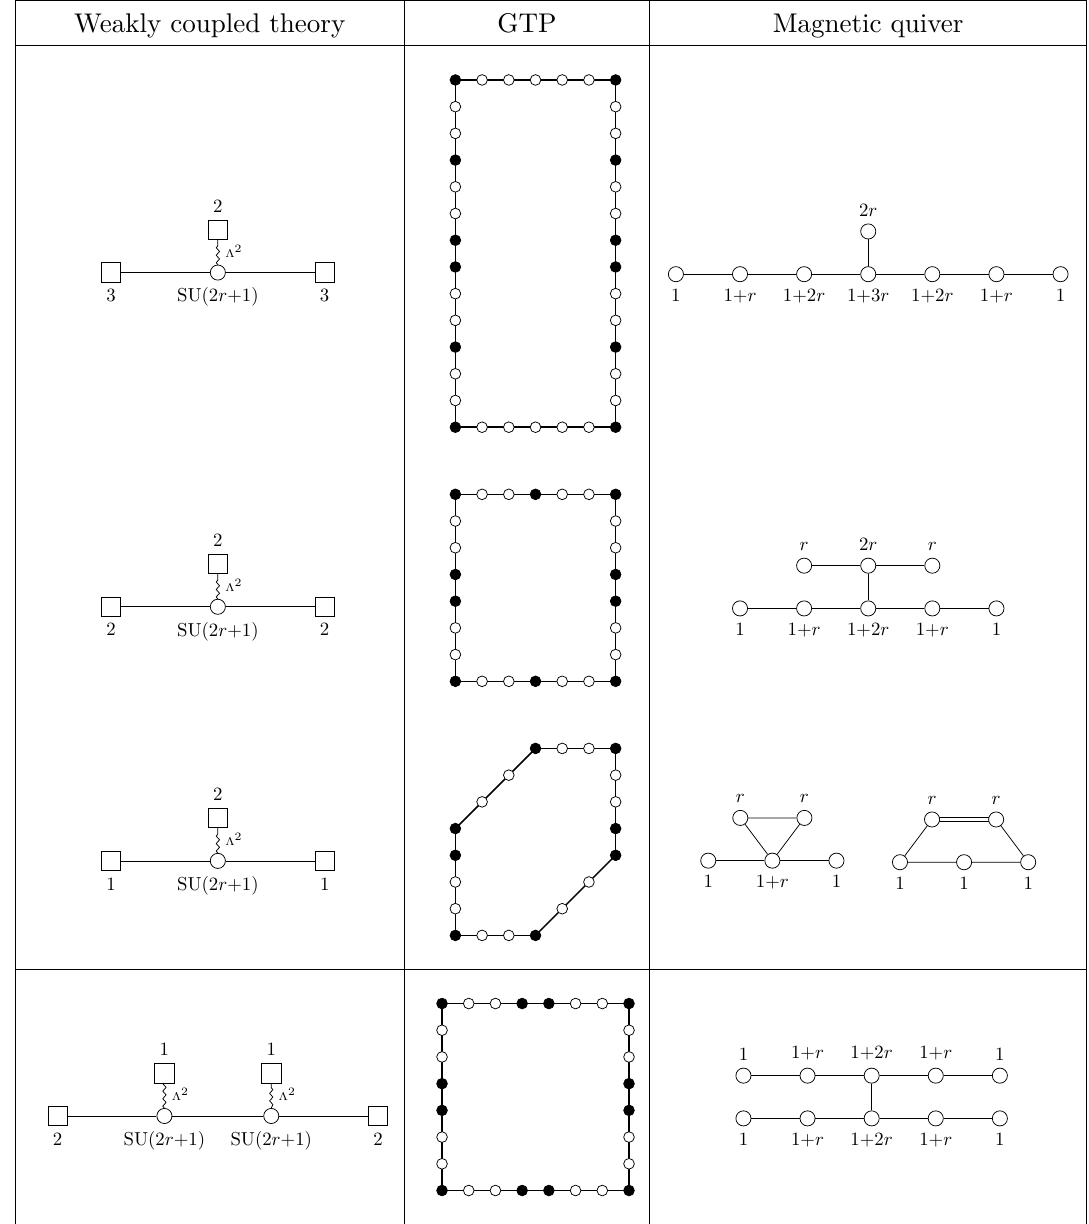
Table 9. For each 5d SCFT, which is the 5d N = 1 UV completion of the weakly coupled theory, one can construct the generalized toric polygon and deduce the corresponding magnetic quiver. This gives all the quivers for ‘ = 2 and ‘ = 4 upon Z folding. In the GTPs, every edge with white ‘ dots should contain exactly r − 1 white dots ( r = 3 is drawn). Note that the last quiver differs from the one of figure 9, illustrating the fact that a quotient on the brane web and on the quivers are different